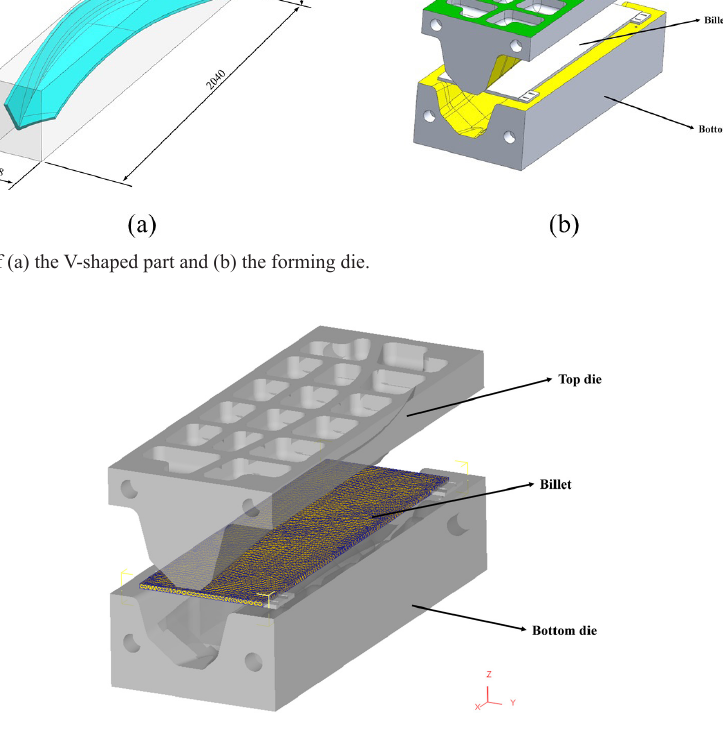
Figure 13. The finite element analytical model of the forming process of the V-shaped part.